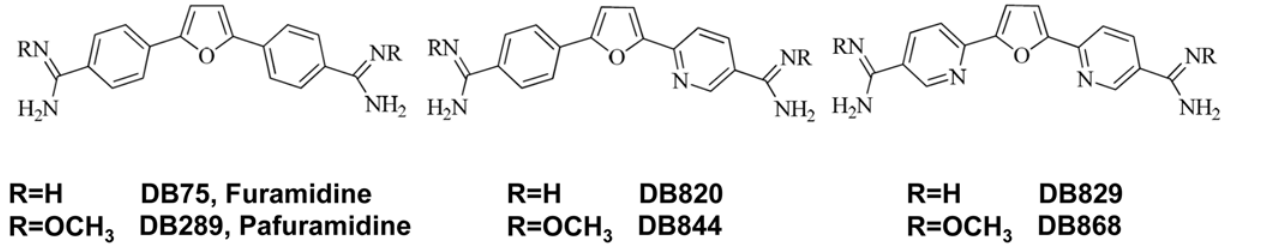
Fig 1. Structures of active diamidines and corresponding